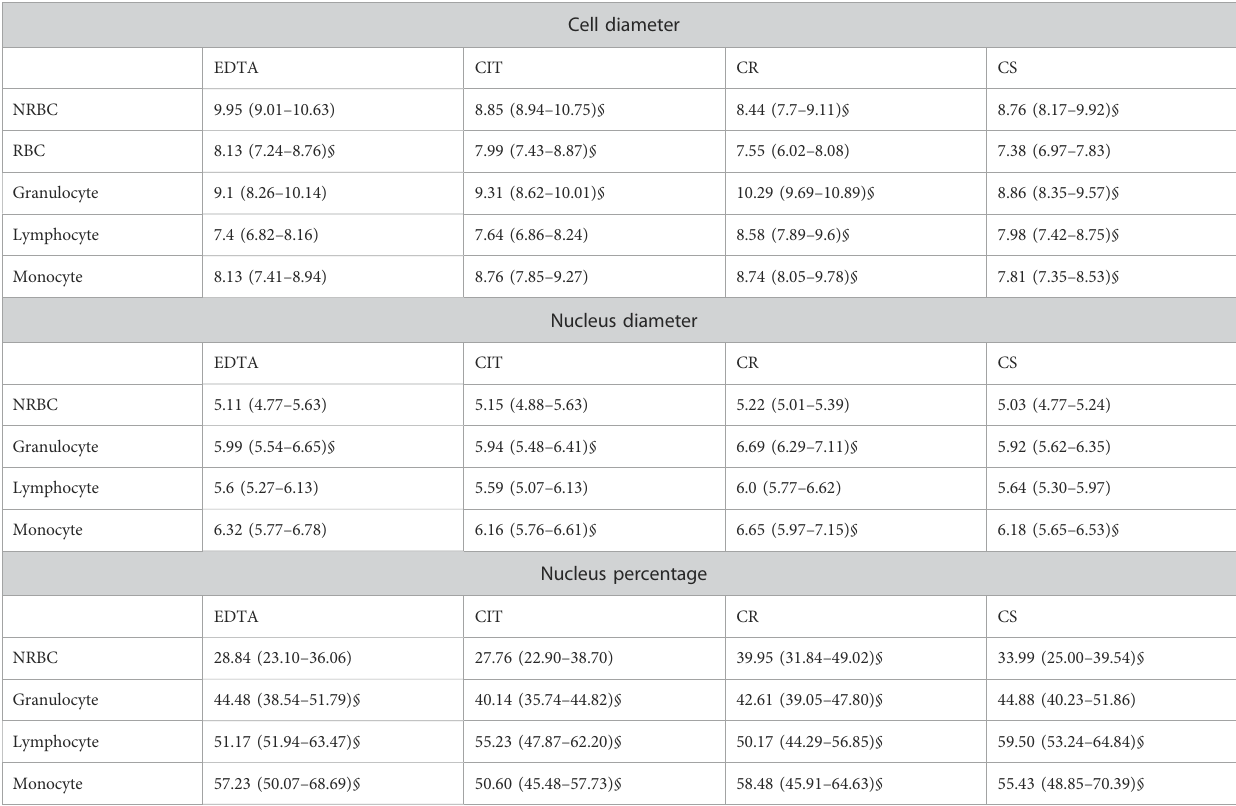
TABLE 4 Cell diameters, nucleus diameters, and nucleus percentages for each cell group for each tube. The data are reported as median (1st – 3rd